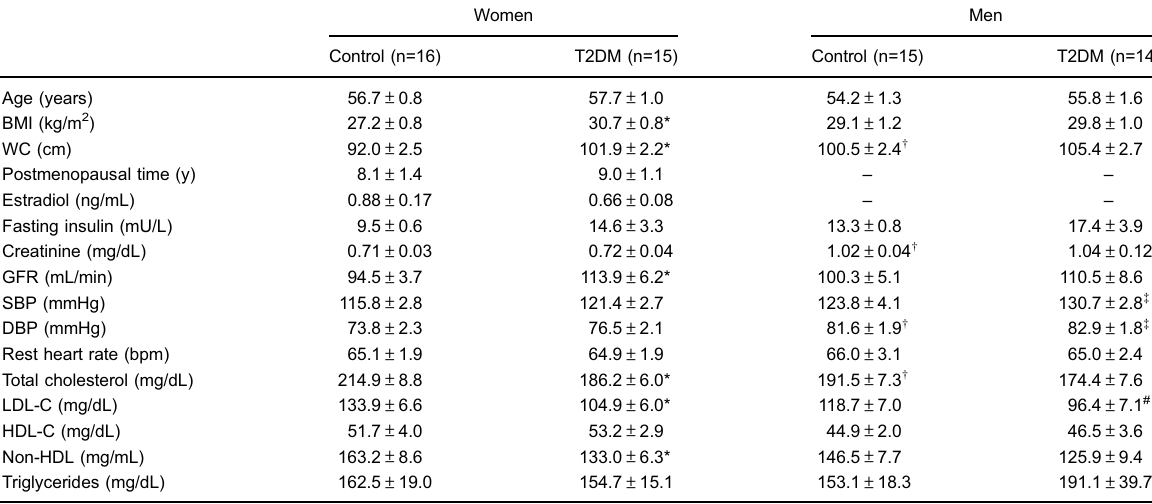
Table 1. Characteristics of the study